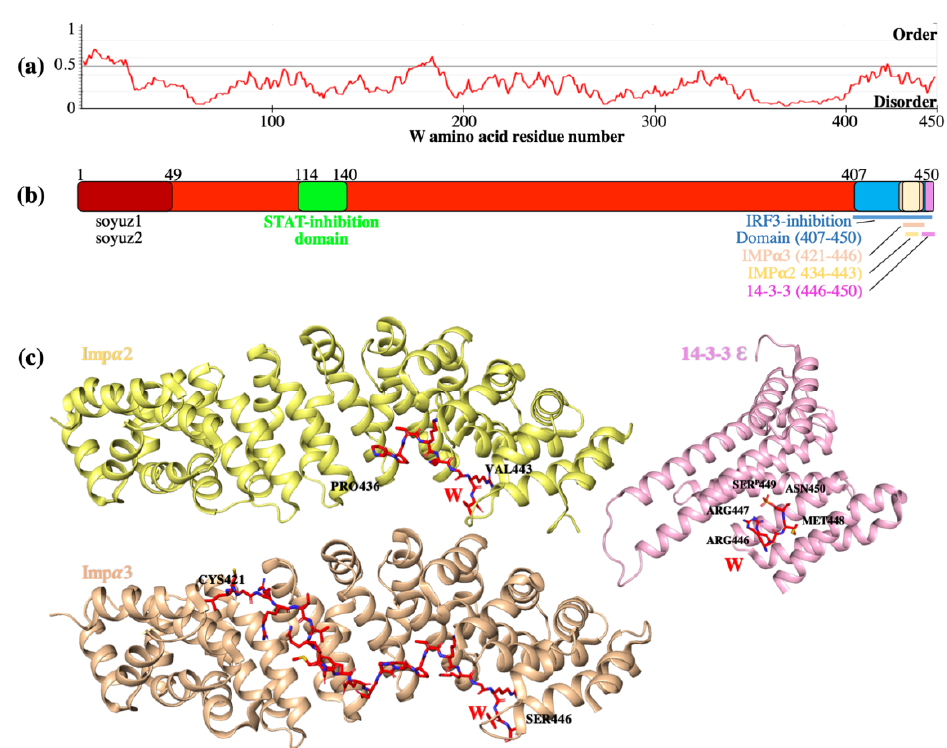
Figure 2. Representation of W protein domains and amino acids sequence involved in host protein interactions. ( a ) The bioinformatics program IUPred2A [40] was used to predict disordered regions across the HeV W protein sequence (UniProt accession number P0C1C6). IUPred2A uses statistical potentials to generate energy estimations of amino acid residues (whether they are likely to form favourable interactions with each other). Residues with scores < 0.5 are predicted to be disordered, whereas residues scored > 0.5 are likely ordered. ( b ) The N-terminal domain of W protein (grey) is an intrinsically disordered region and contains region aa 114-140 (green) that is paramount for signal transducer and activator of transcription (STAT) binding (green) and inhibition. Soyuz1 and soyuz2 regions (dark grey) are highly conserved in henipaviruses and may play a role in interferon (IFN) antagonism. The C-terminal domain of residues 408 to 450 is required for interferon regulatory factor 3 (IRF-3) inhibition (blue) and includes the Imp α 2 (yellow) and Imp α 3-binding region (orange), vital for nuclear localisation, and the 14-3-3-binding region (pink). ( c ) Solved structures of W NLS (red) in complex with binding partners: Imp α 1 in yellow (PDB 6BW0), Imp α 3 in orange (PDB 6BVV), and 14-3-3 σ in pink (PDB 6W0L).